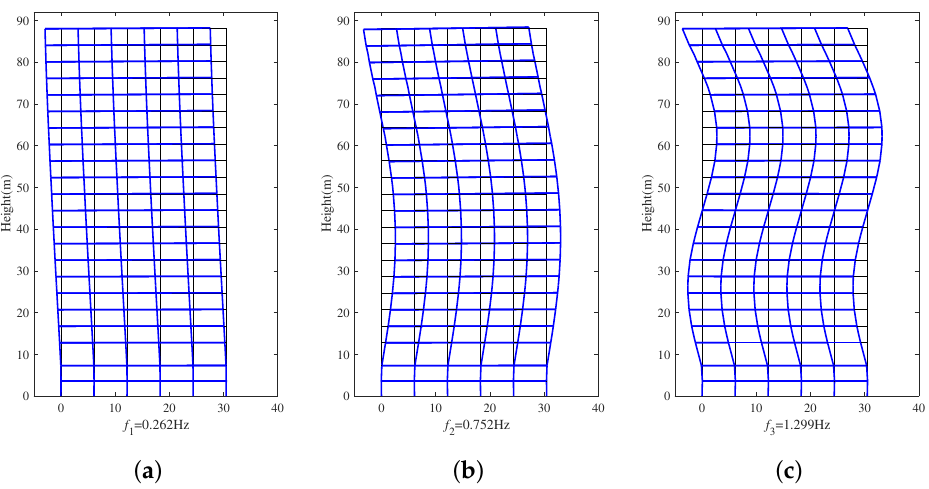
Figure 14. The first three mode shapes of the structure: ( a ) Fundamental mode; ( b ) Second mode; ( c ) Third